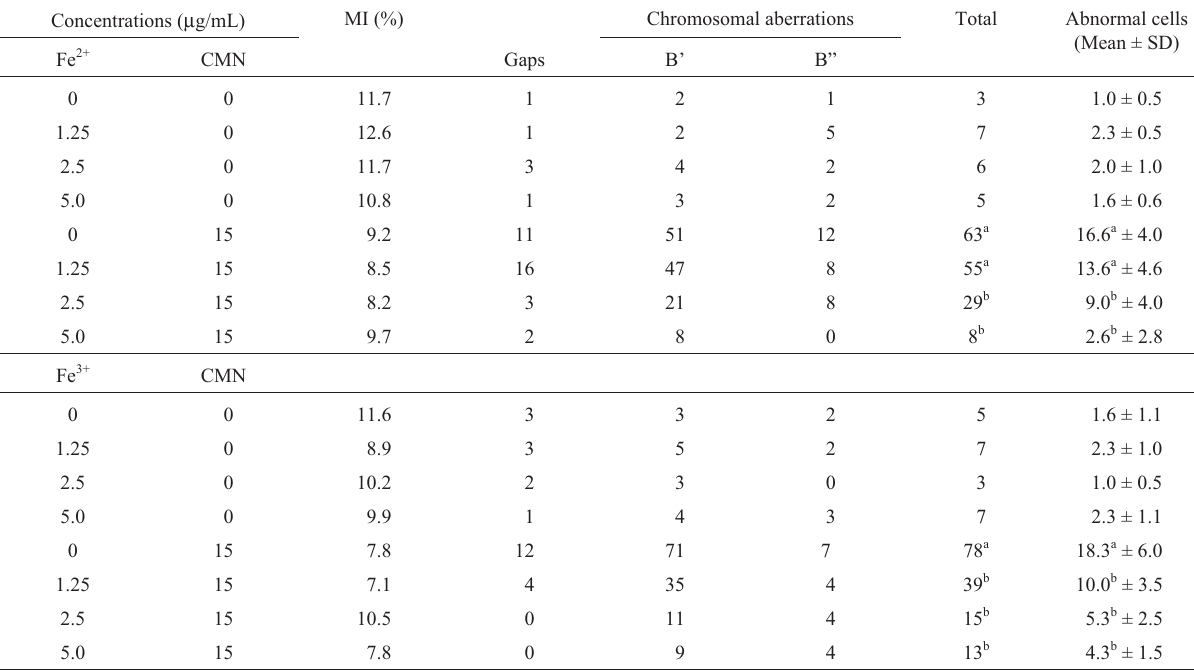
Table 2 - Effects of different concentrations of Fe 2+ and Fe 3+ on chromosomal aberrations induced by curcumin (CMN) in CHO cells. Concentrations ( µ